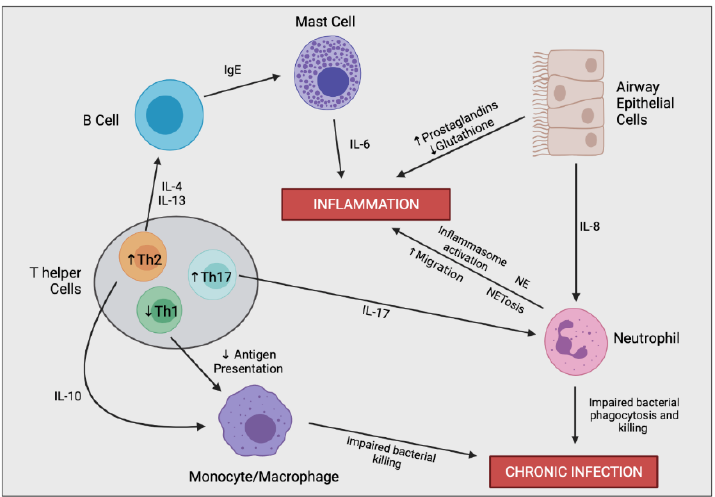
Figure 3. Simplified schematic outlining the complex immune cell interaction involved in producing the hyperinflammatory response and chronic infection in CF. In the CF airway, airway epithelial cells (AECs) secrete increased levels of IL-8, resulting in enhanced neutrophil migration. Perturbed secretion of prostaglandins and glutathione from AECs promotes inflammation. Neutrophils are the predominant driver of airway inflammation through multiple mechanisms including increased inflammasome activation, increased secretion of neutrophil elastase (NE), and a bias towards neu- trophil extracellular trap (NET)-mediated cell death (NETosis). Neutrophils also possess impaired bacterial phagocytosis and killing leading to insufficient bacterial clearance and chronic infection. CF-macrophages also secrete increased levels of IL-8 and other proinflammatory mediators (not shown), promoting neutrophil infiltration and further inflammation directly. CF-macrophages also undergo impaired bacterial killing encouraging persistent infections. T helper cells in CF are skewed towards Th2 and Th17 differentiation rather than a Th1 phenotype. Th17 cells secrete IL-17, pro- moting neutrophil infiltration, as well as other proinflammatory cytokines which contribute to the hyperinflammatory response (not shown). Th2 cells stimulate a pro-allergic response involving in- creased secretion of IL-4 and IL-13 leading to IgE production. Th2 cells also secrete IL-10, dampen- ing the expression of co-stimulatory molecules on macrophages causing decreased antigen presen- tation and impaired bacterial clearance.